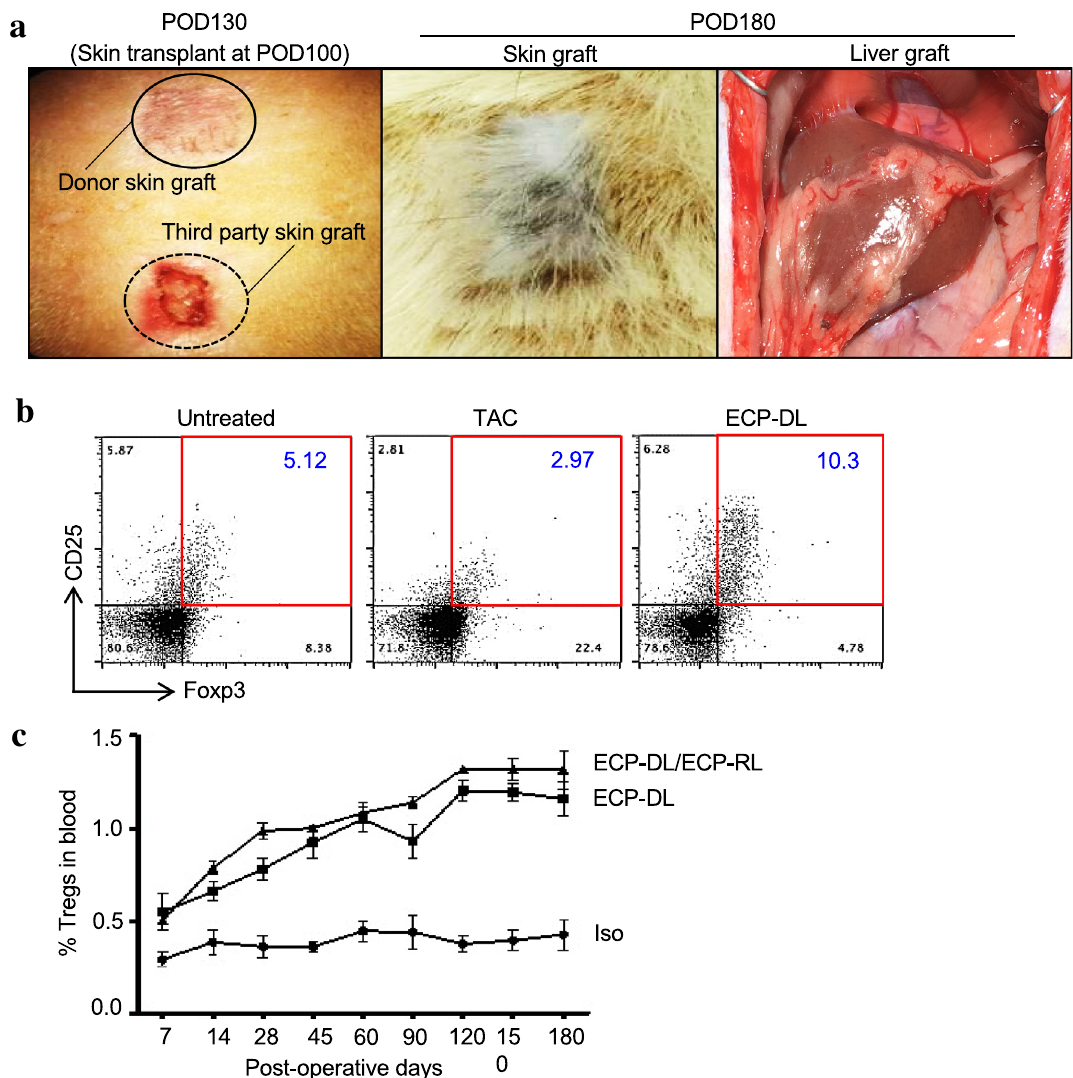
Figure 8. ECP-DL induced hypo-responsiveness is donor-specific and is associated with increased frequency of circulating T-regulatory cells. Lewis rats received orthotopic liver grafts from ACI donors 7 days after injection of ECP-DL without additional IS. Skin grafts from both donor (ACI) and third party (BN) rats were applied to the same recipient 100 days post-liver transplant to determine whether the tolerance is donor specific. Animals were monitored, and serial blood samples were analyzed by flow cytometry for the frequency of Tregs. ( a ) Representative gross images showing the donor-type skin grafts at post-operative (POD) 130 versus third- party skin grafts. By POD 180, the donor-type skin grafts further improved in appearance, while third-party skin grafts ulcerated, indicating rejection; the liver graft appears normal in situ. ( b ) Representative dot-plot showing % of Tregs, and a bar graph of the number of Tregs in the blood at POD7 showing higher percentage and absolute numbers of Tregs in ECP-DL treated recipients than the untreated or those receiving short-course tacrolimus (TAC). ( c ) The percentage of Tregs over the course of the experiment; animals receiving either ECP-DL or ECP-DL/ECP-RL had significantly higher percentages of Tregs than isograft controls at all time